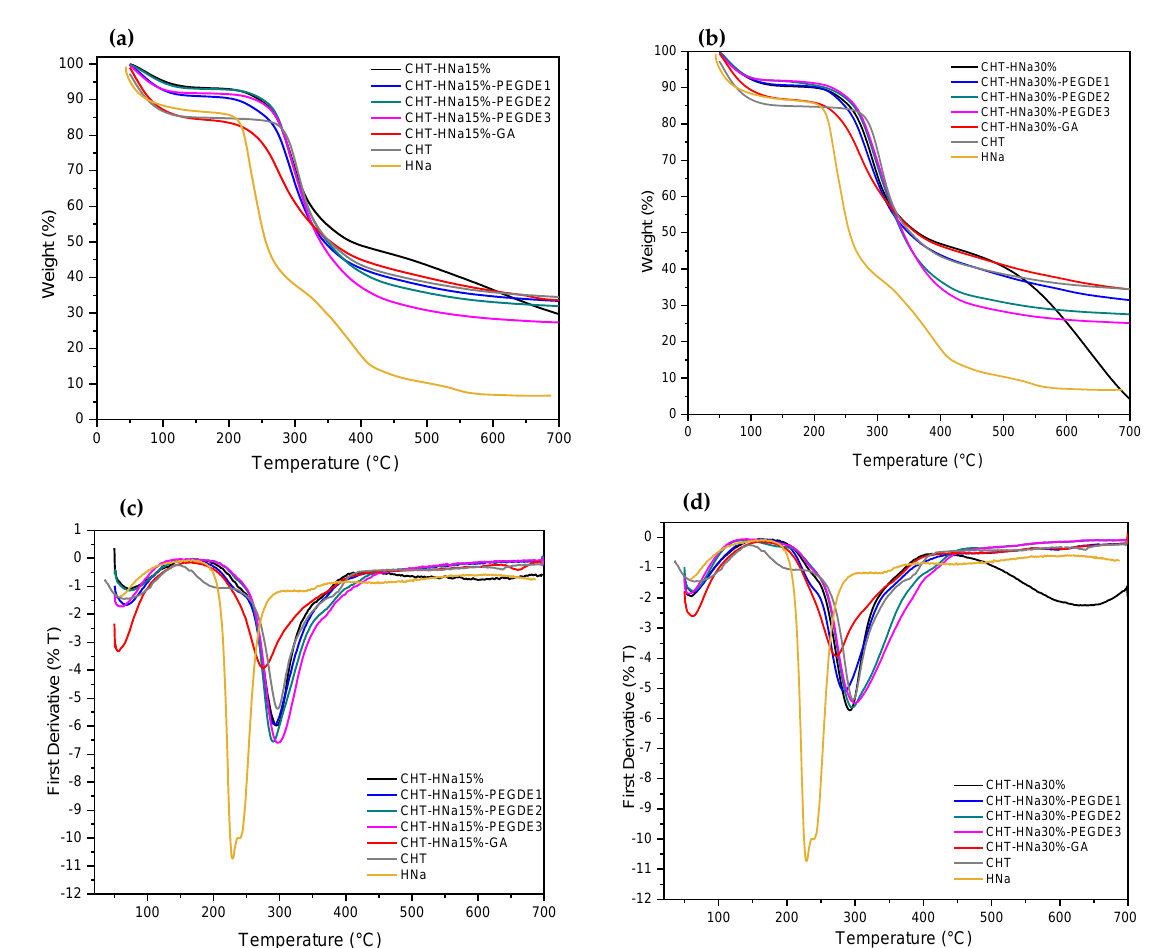
Figure 3. TGA and DTGA thermograms of GA crosslinked and PEGDE crosslinked chitosan/HNa films. TGA ( a , b ) and DTGA ( c , d ). HNa content of 15% ( a – c ), HNa content 30% ( b – d ). Table 2. Decomposition temperatures and weight loss of CHT films, CHT/HNa at 15% and 30% films crosslinked with GA and